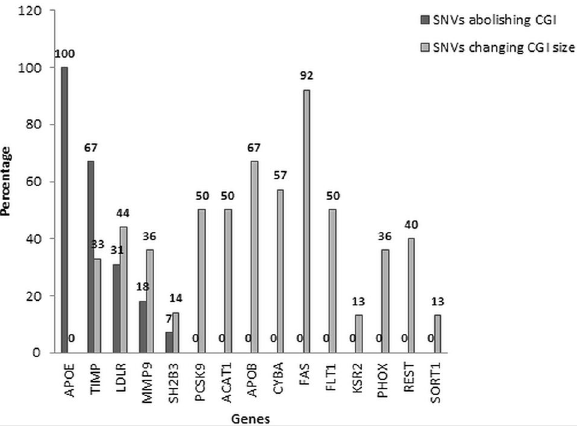
Transcription factors Gene Single nucleotide variations (rs number; variation) Wild type allele Variant allele rs1026272027,G/T* C/EBPapl C/EBPbet rs887608252,C/T* No TF C/EBPapl Low density lipoprotein receptor ( LDLR ) rs1006494933,G/A* No TF GATA-1, Oct-1 rs532491368,G/A rs1024897634,C/T* Oct-1 rs139620474,C/A/T –A or Matrix metalloproteinase 9 ( MMP9 )